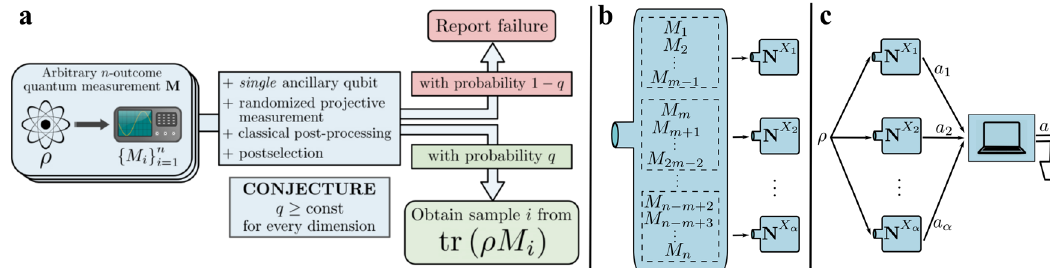
Fig. 1 Implementation of a target measurement M with POVMs having at most m outcomes and postselection. Left fi gure illustrates a general idea of the scheme, while in the right fi gure the method is illustrated in more detail – in b , the m -outcome POVMs N X using effects of M that correspond to different subsets X γ forming a partition of [ n ] into subsets of cardinality m − 1 ( fi gure shows the standard partition and effects of [ n ]: X 1 ¼ 1 ; 2 ; (cid:3)(cid:3)(cid:3) ; m (cid:4) 1 f g , X 2 ¼ m ; (cid:3)(cid:3)(cid:3) ; 2 m (cid:4) 2